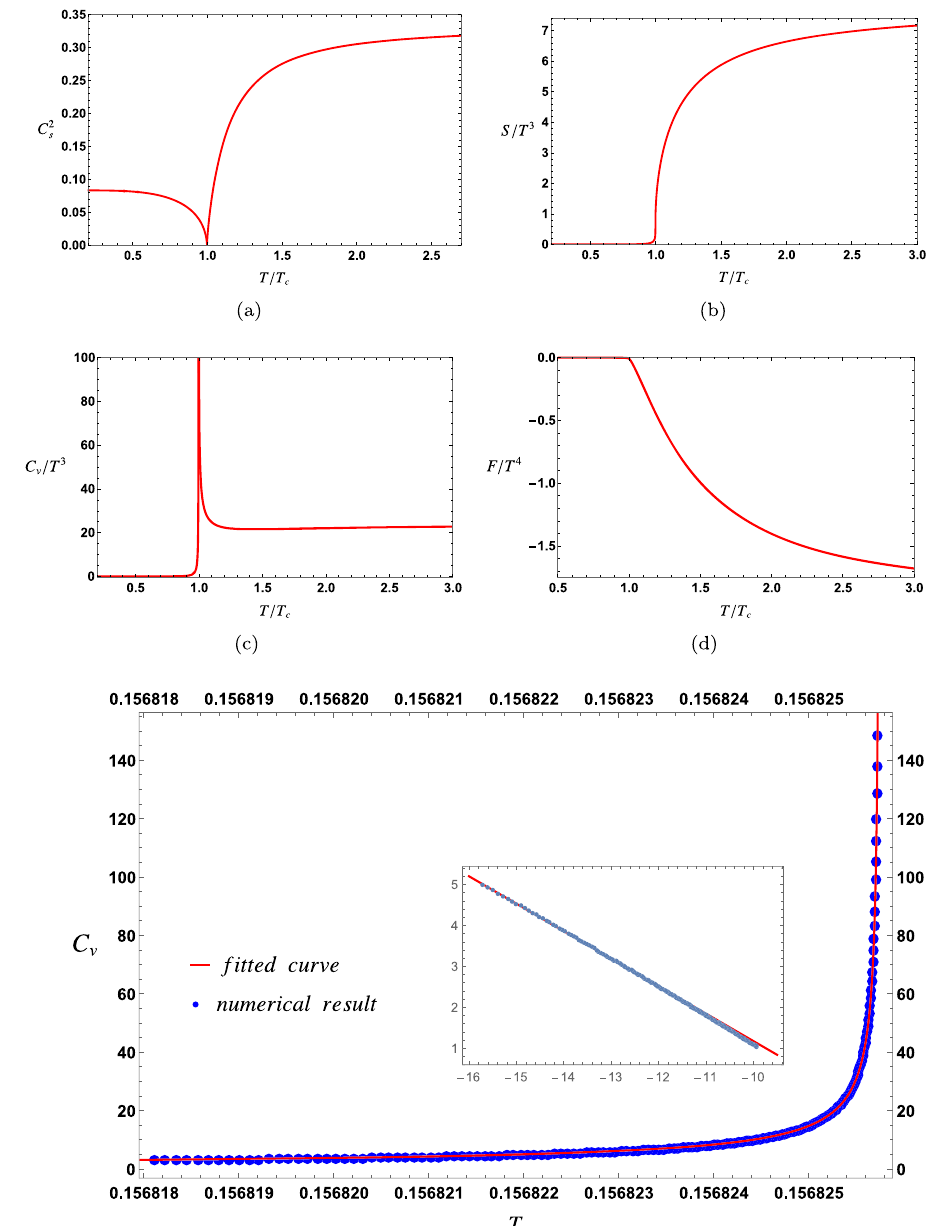
Fig. 3 The square of speed of sound c 2 s ( a ), entropy density s ( b ), specific heat C v ( c ) and free energy F ( d ) v.s. temperature T